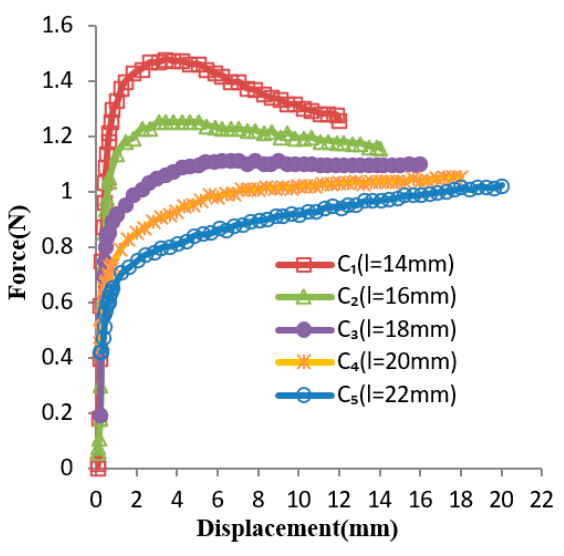
Figure 8. Force–displacement experimental curves, with l half as the design variable.